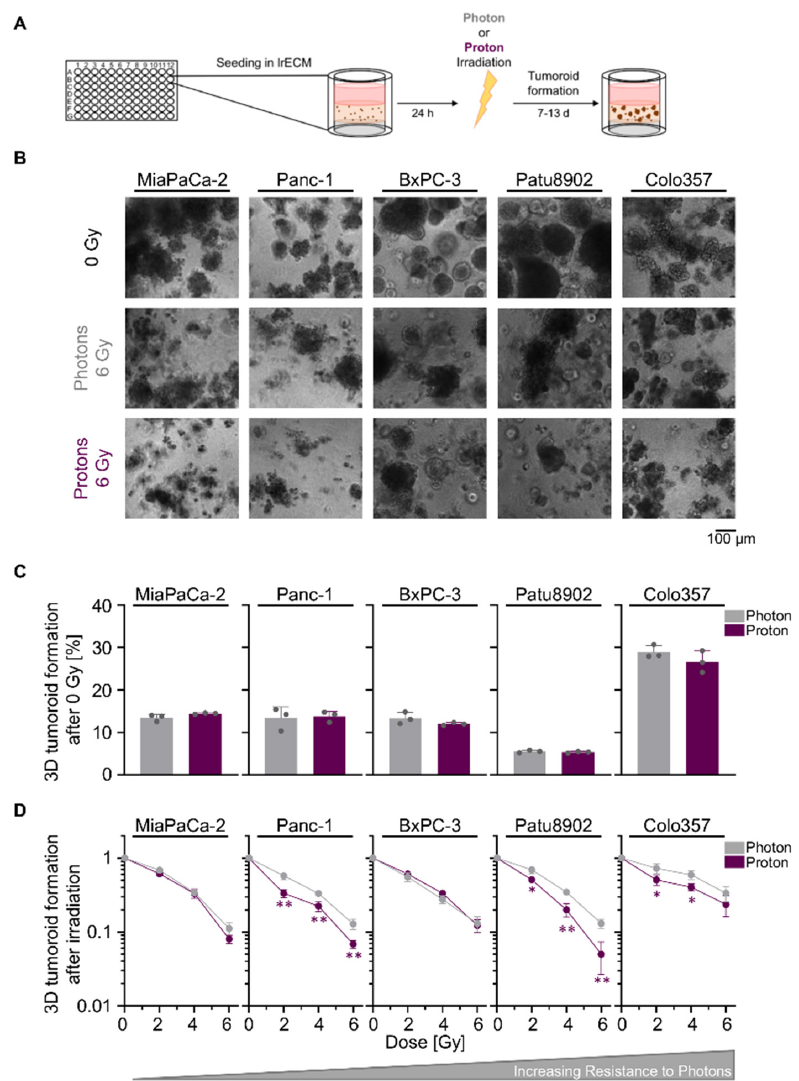
Figure 1. Proton irradiation tends to be more effective in reducing pancreatic ductal adenocarcinoma (PDAC) tumoroid growth than photon irradiation. ( A ) Experimental set-up for examining 3D PDAC tumoroid growth; ( B ) Representative bright-field images of unirradiated, 6-Gy photon and 6-Gy proton irradiated 3D PDAC tumoroids, scale bar: 100 µm; ( C ) 3D tumoroid formation capacity without irradiation; ( D ) 3D PDAC tumoroid growth after irradiation with 2, 4 or 6 Gy of photons and protons. Cell lines are ordered by increasing resistance to photon irradiation. Results show mean ± SD ( n = 3; two-sided t -test; *, p < 0.05; **, p < 0.01).